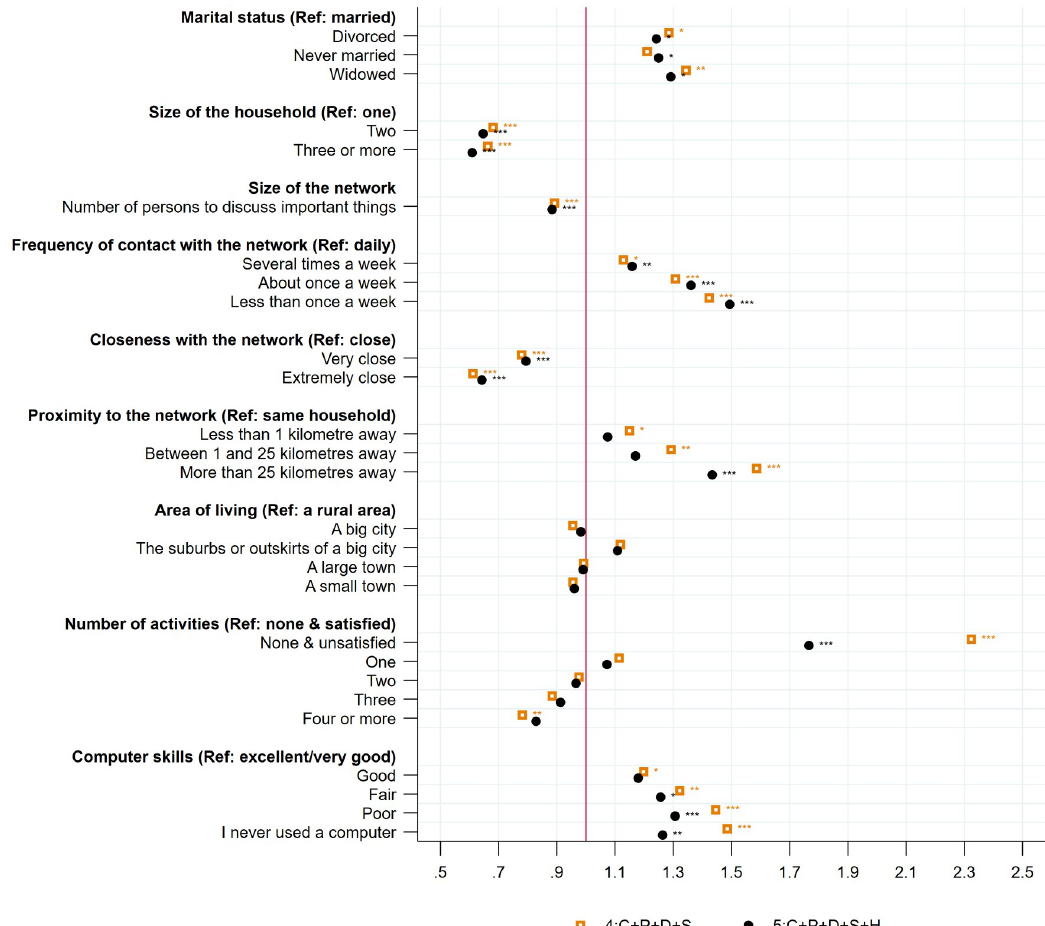
Fig 4. Loneliness at age 50+: The role of social support. Note: The figure displays odds ratios of social support, activities, and network variables at age 50+ for two different specifications. Specification (4) includes S, social support, activities, and network variables at age 50+; D, a set of individual socioeconomic and demographic variables at age 50+; P, a vector of the five scores of personality traits (extraversion, agreeableness, conscientiousness, neuroticism, openness); C, a vector of childhood circumstances (wealth; health; quality of the relationship with mother, father, and friends; importance of religion); and I, country-specific fixed effects. Specification (5) includes (4) and H, a vector of individual health information at age 50+. Reading example: in the full specification, being divorced increases the risk of loneliness by 1.24. The pseudo R 2 and the proportion of correctly specified outcomes are respectively for each specification: (1): 0.0364; 82.89%, (2): 0.0600; 82.99%, (3): 0.0864; 82.96%; (4): 0.1181; 83.39%, (5): 0.1699; 84.09%. � p < 0.05, �� p < 0.01, ��� p <